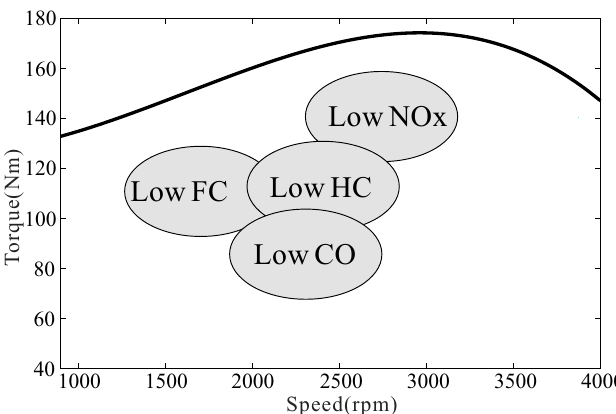
Figure 2. Fuel efficiency and emissions tradeoffs for an spark ignition (SI) engine.